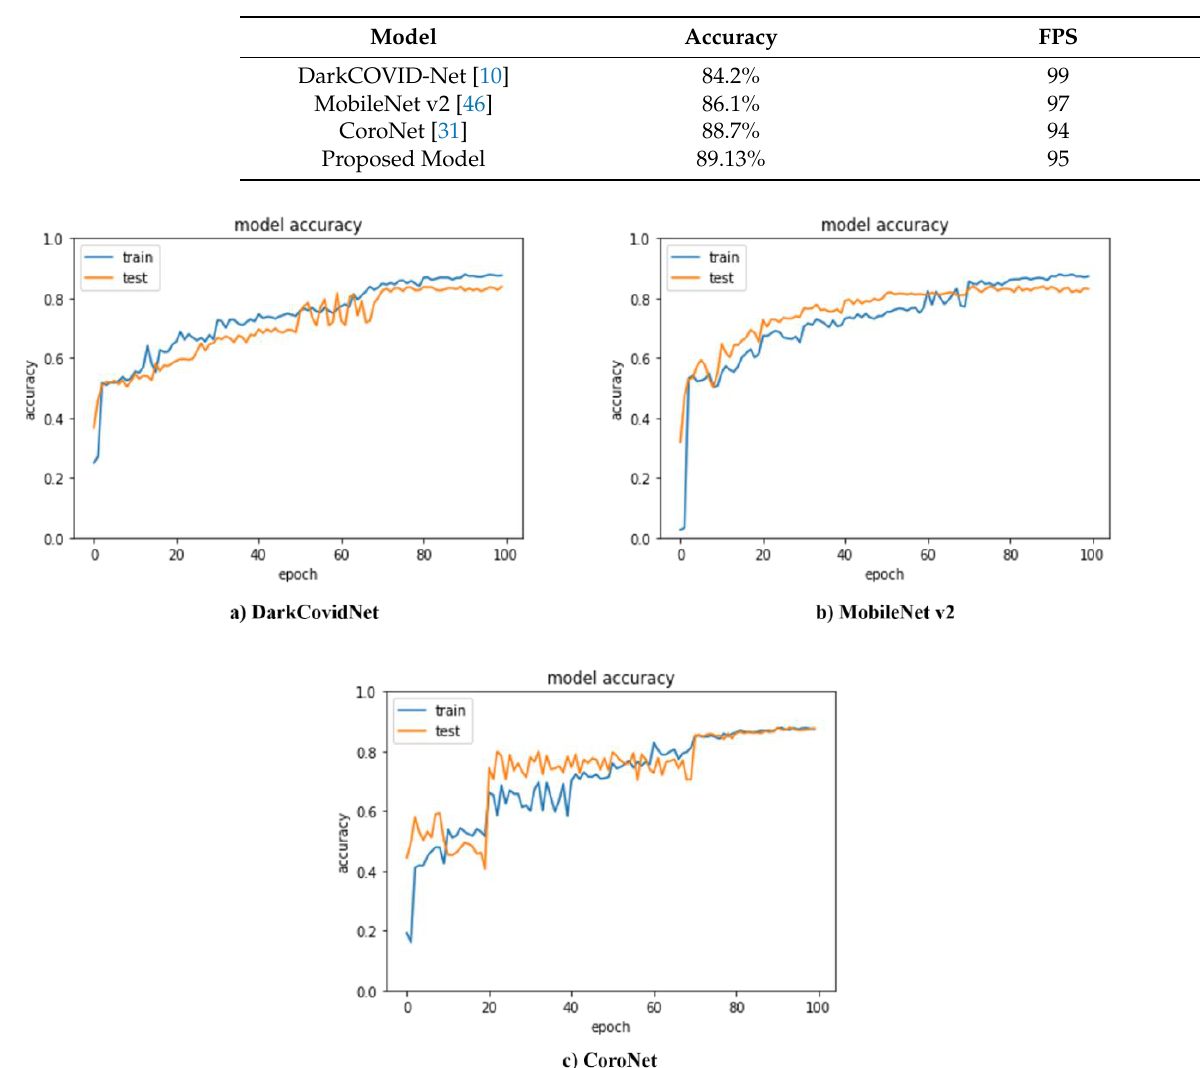
Figure 7. Accuracy of various state-of-the-art classifiers a ) DarkCovidNet [10], b ) MobileN2t v2 [31] and c ) CoroNet [46] .